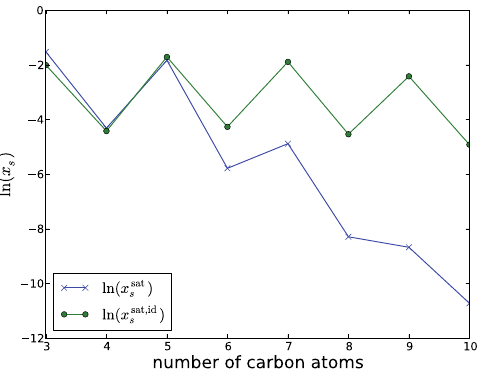
Fig. 4. Enthalpies and entropies of fusion and solution for lin- ear diacids, and their differences. Note that for the enthalpies 1H/(RT ref ) , T ref = 298 . 15K is plotted, and for the entropies 1S/R